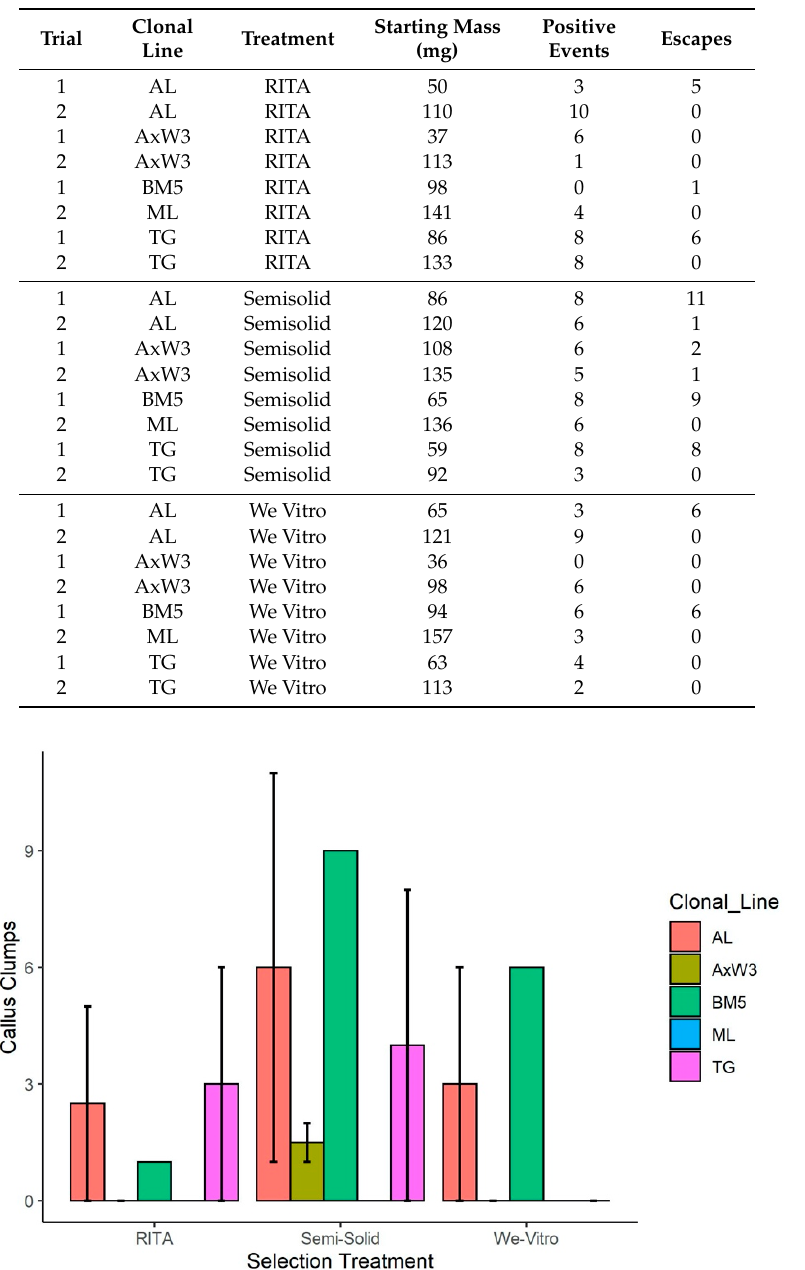
Figure 4. American chestnut somatic embryo line escapes (non-transformed tissue surviving on selection medium). Error bars indicate standard error of the mean. Two clonal lines, BM5 and ML, were only used in single trials. Table 1. Number of positive events and escapes per starting mass in transformation using p35S-OxO.